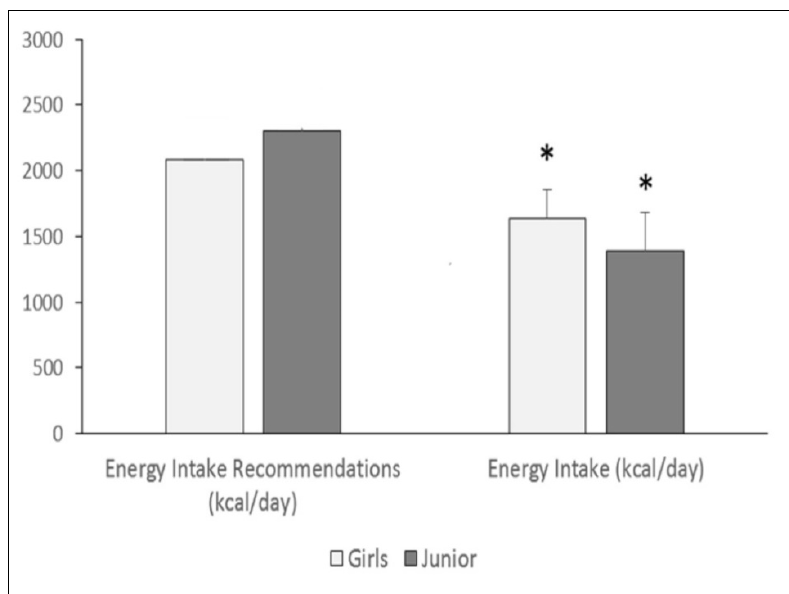
Figure 1. Recommended and measured average energy intake by age group (pre-teen vs. teen), compared to recommendations [25] (* p < 0.05 considered significant).